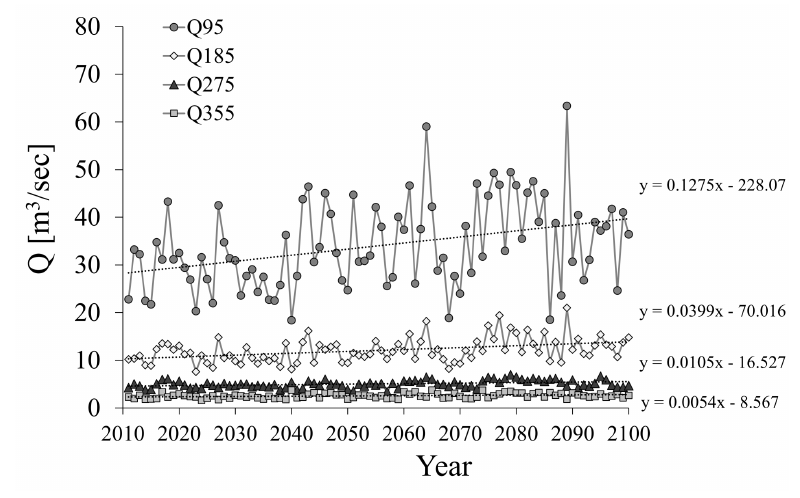
Figure 12. Future variation of stream flow regime. Table 7. Projections for coefficient of river regime and flow duration by three decadal spans.